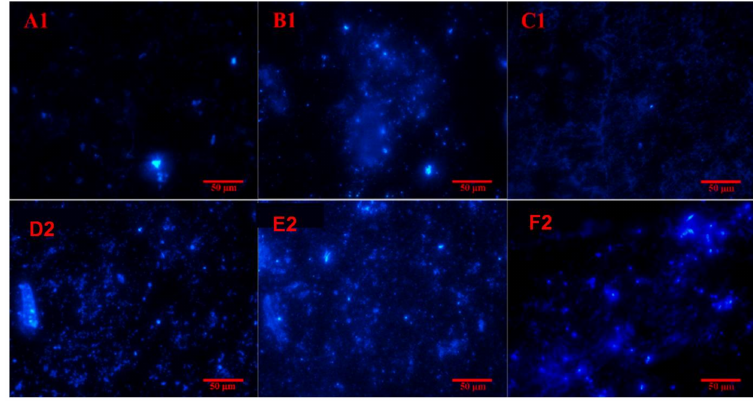
Figure 5. The EFM images of cells of S. metallicus adsorbed on the surface of ( A , D ) untreated chalcopyrite; ( B , E ) chalcopyrite treated at 0.87 V; ( C , F ) treated at − 0.54 V. The suffix “1” indicates day 2; suffix “2” indicates day 4.